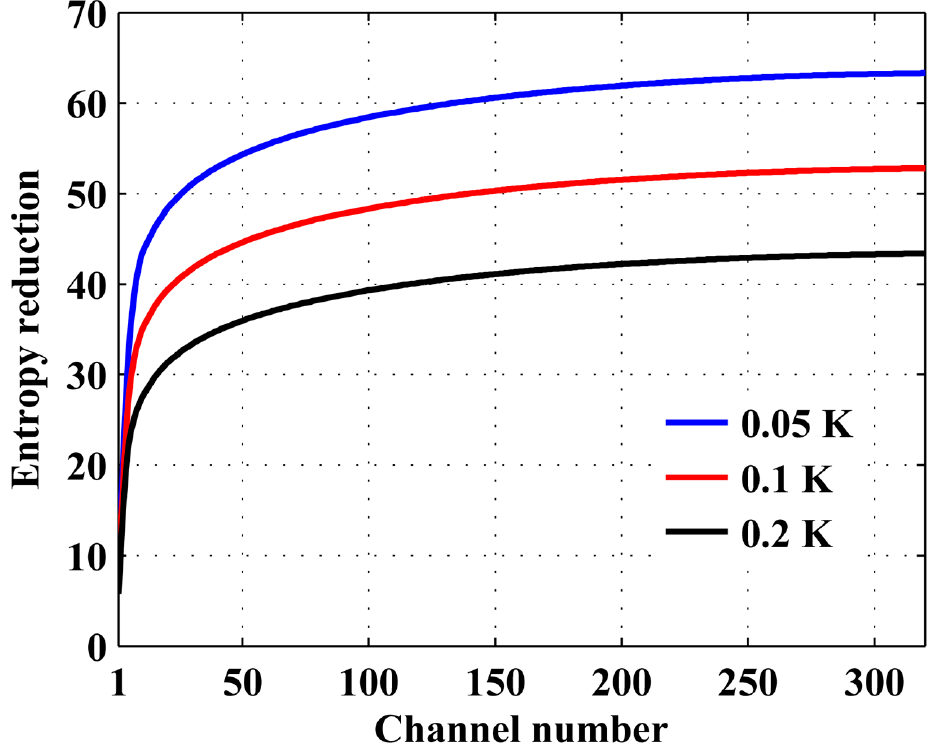
Figure 12. The information content provided by the sounder with different instrumental noises. (Entropy reduction represents the difference of the information entropy before and after the retrieval, which is the information content observed by the sounder. [13]) .